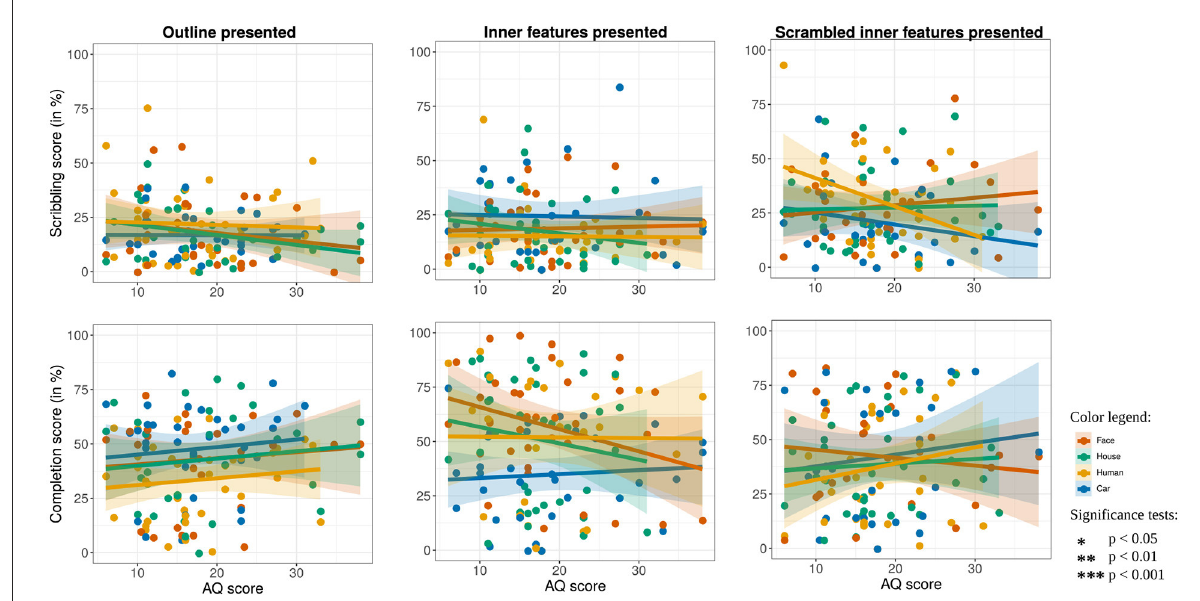
FIGURE6 How scribbling (top) and completion score (bottom) depends on the AQ score of the children, separately displayed for drawings where the outline (left) , the inner features (middle) , and the scrambled features (right) were presented. The colors refer to the category of the presented stimuli. Each point represents the average score of all ratings of one child drawing, and the lines show linear model